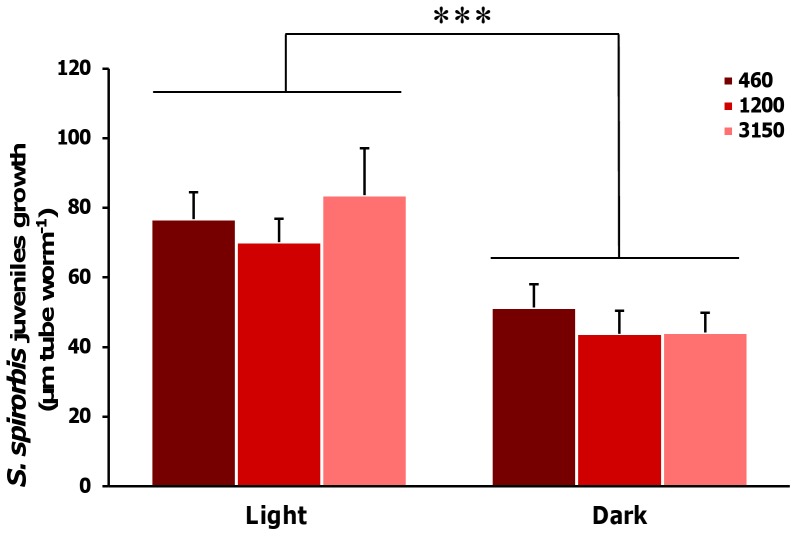
Growth of the juveniles of S. spirorbis.Growth in µm of the tubes of the juveniles of S. spirorbis during 24 h in light and dark condition exposed to pCO2 of 460 µatm, 1200 µatm and 3150 µatm. Data are the mean ± SE newly formed tubes sections in µm per worm per flask Two-way ANOVA, n = 5, statistical significance: ***: p≤0.001.